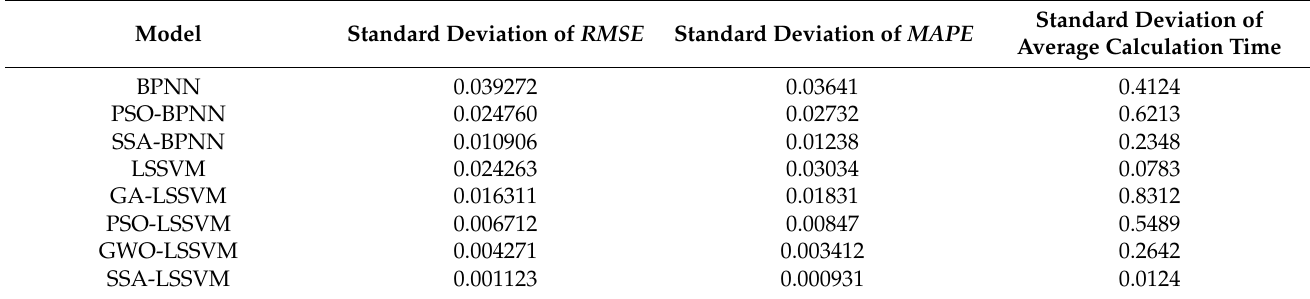
Table 15. Stability analysis of different calculation